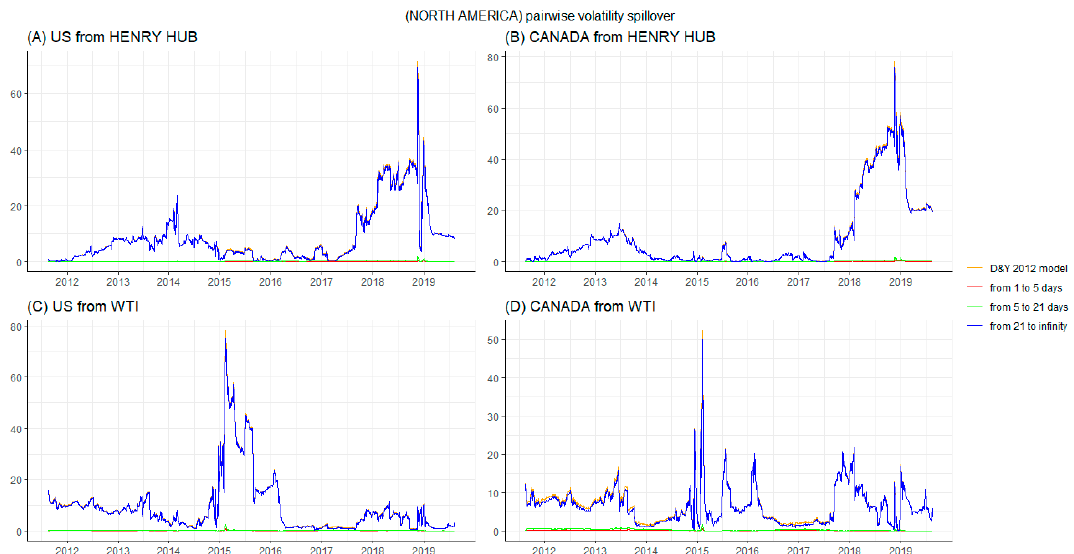
Figure A3. Pairwise directional volatility spillover of DY12 and BK18 in North America. Notes: US from HENRY HUB indicates the volatility spillover from natural gas to US; CANADA from HENRY HUB indicates the volatility spillover from natural gas to Canada; US from WTI indicates the volatility spillover from crude oil to US; CANADA from WTI indicates the volatility spillover from crude oil to Canada.